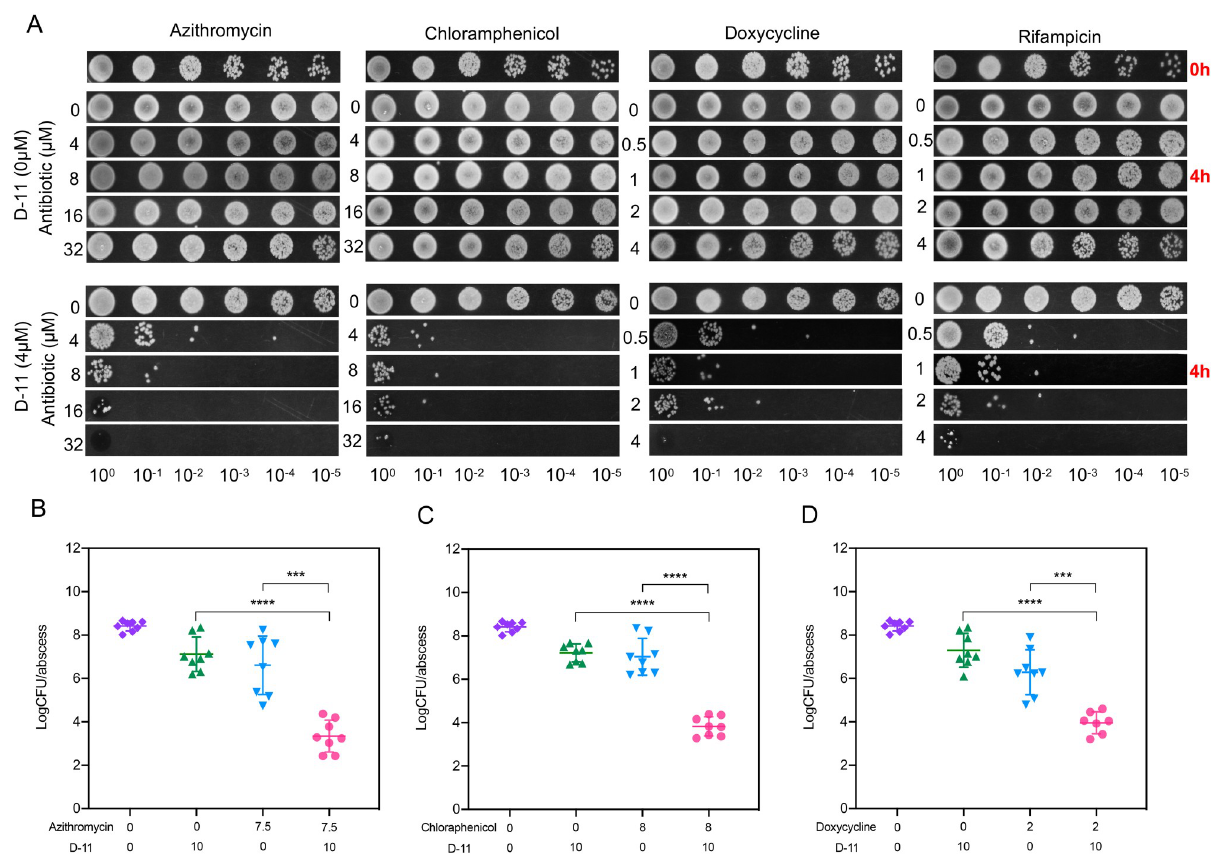
Fig 7. D-11 enhances the activities of multiple antibiotics ex vivo and in vivo . ( A ) Ex vivo bacteremia model for antibiotics, D-11, and their combinations antimicrobial activity. 10 μ L of serial decimal dilutions of each one of the combinations of antibiotics with/without D-11 (4 μ M) tested in blood were dropped. In vivo efficacy of azithromycin (7.5 mg/kg) ( B ), chloramphenicol (8 mg/kg) ( C ), doxycycline (2 mg/kg) ( D ) and D-11 (10 mg/kg) alone or their combination against P . aeruginosa PAO1 (n = 7 for doxycycline and D-11, n = 8 for the other groups). All the three experiments are using the same group of negative control which treatment with saline. All the data are presented as mean ± SD. ��� , P < 0.001; ���� , P < 0.0001; ns by Student’s t